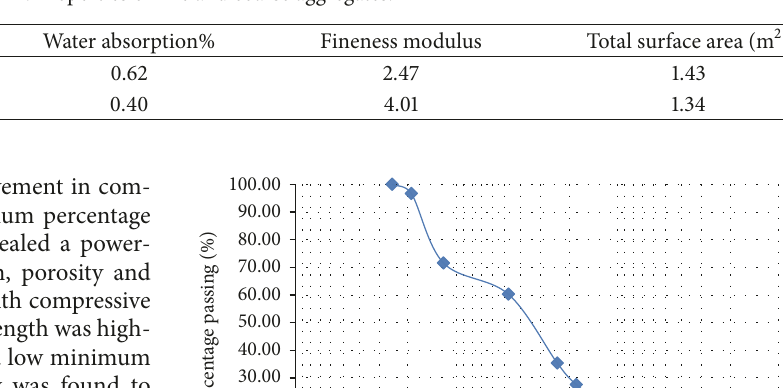
Table 2: Properties of fine and coarse aggregates.